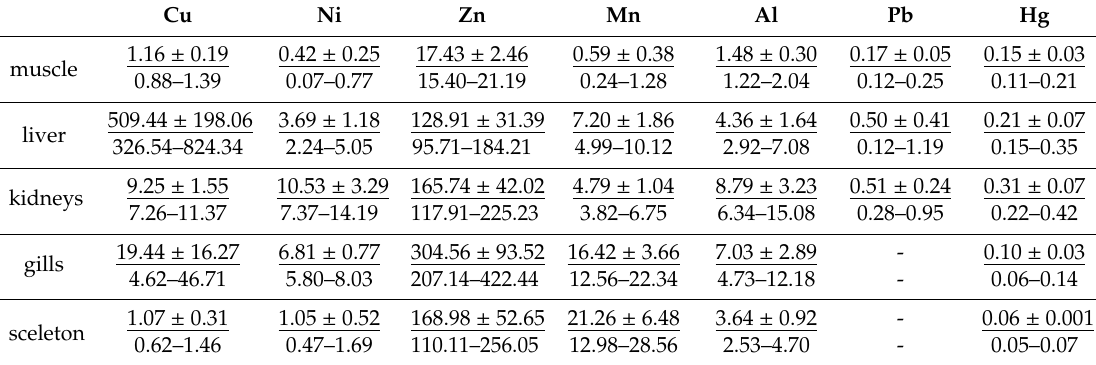
Table 4. The concentration of heavy metals and Al in trout from Lake Kumuzhie in µ g / g of dry weight. Cu Ni